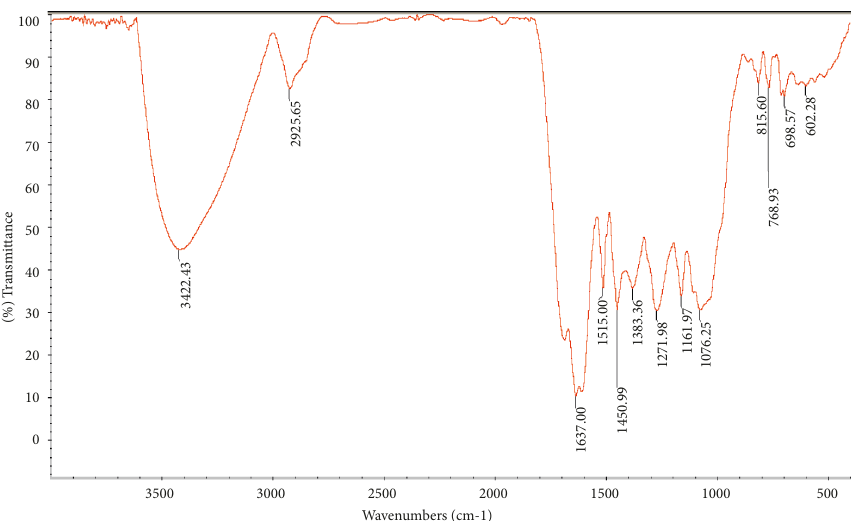
Figure 6: FTIR spectra of CuNPs using propolis (Khalkhal) extract from 400 to 4,000cm − 1